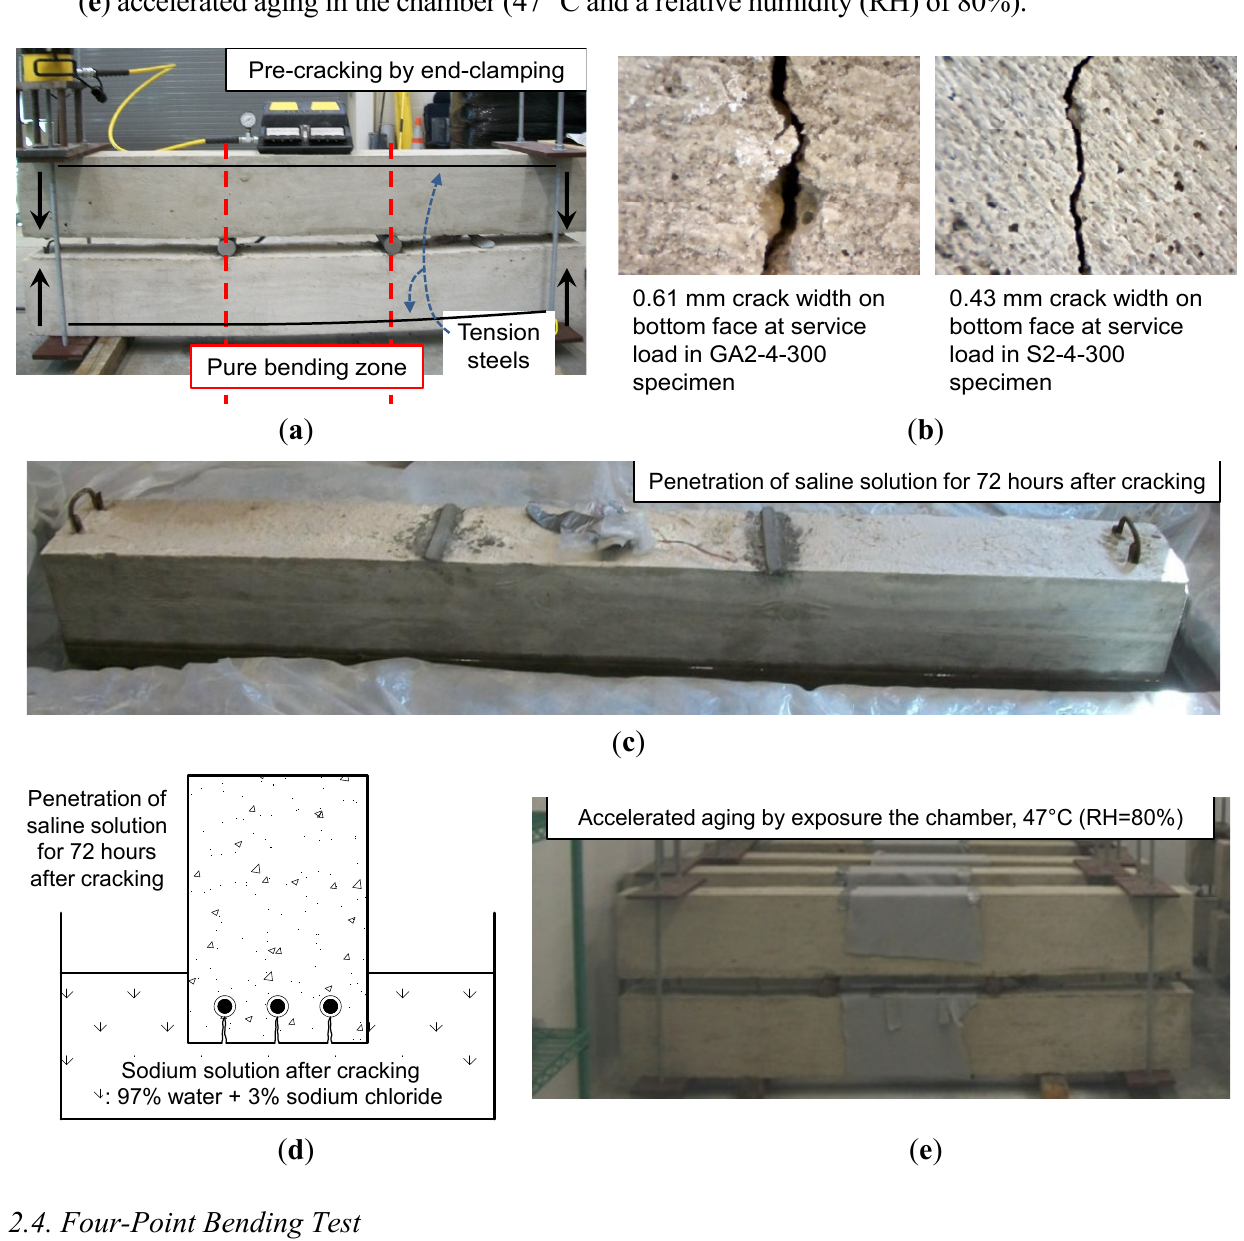
Figure 3. Test procedure: ( a ) pre-cracking for simulating service loading; ( b ) crack widths due to service loading; ( c ) beam immersed in saline solution; (d) penetration of saline solution;